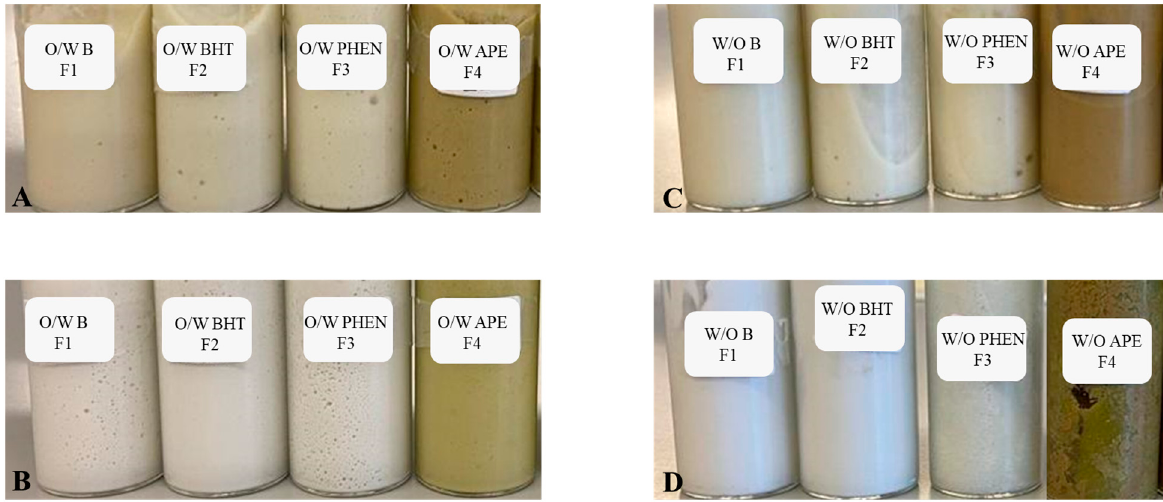
Figure 3. Accelerated thermal stability results of the formulations: O/W before and after the test ( A , B ), respectively, and W/O before and after the test ( C , D ), respectively. F1: base formulation without additives; F2: formulation with BHT; F3: formulation with phenoxyethanol (PHEN); F4: formulation with the avocado peel extract (APE).